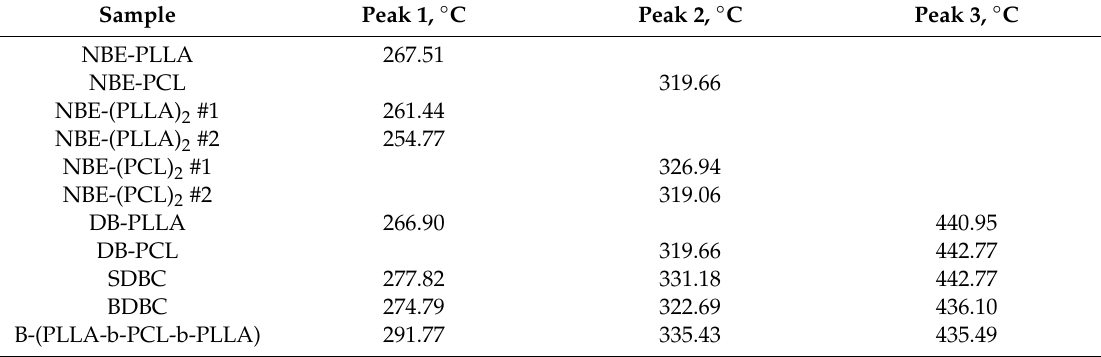
Table 4. Di ff erential Thermogravimetry, DTG results of the macromonomers and the polymer